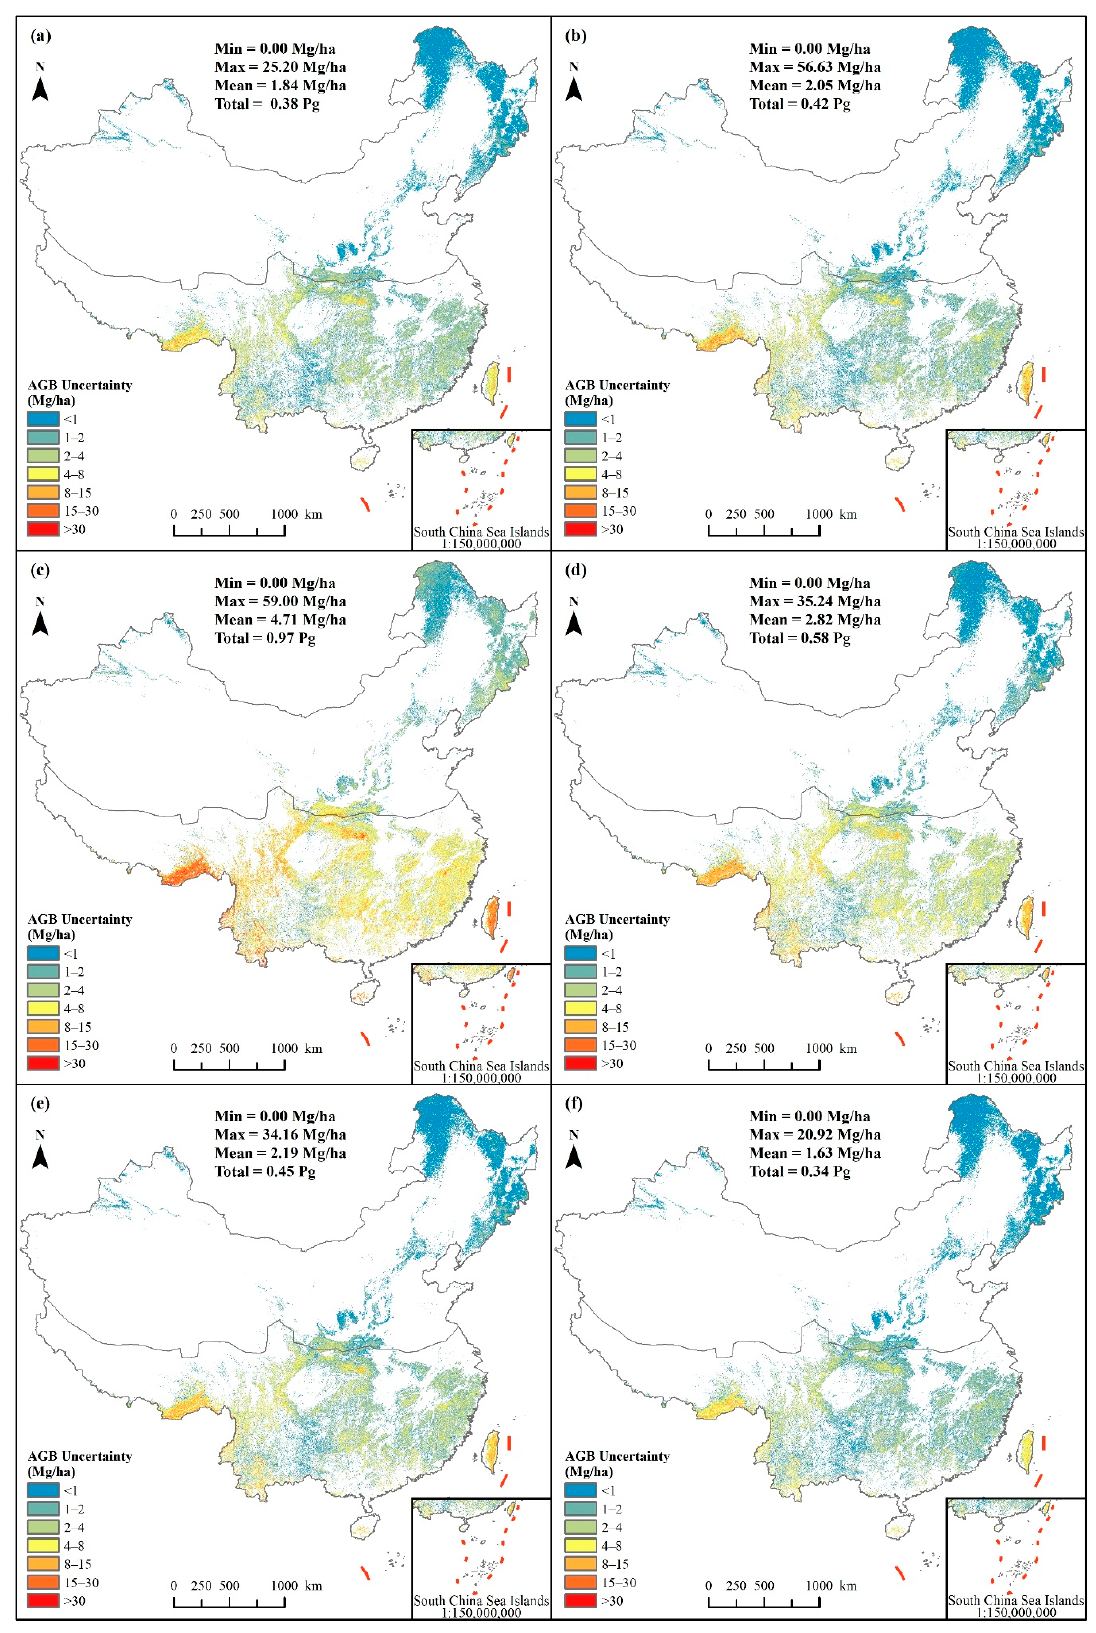
Figure 8. Spatial distribution of forest AGB uncertainty of the six models. ( a ) RF; ( b ) GB; ( c ) XGB; ( d ) LGBM; ( e ) CatBoost; and ( f ) Stacked.